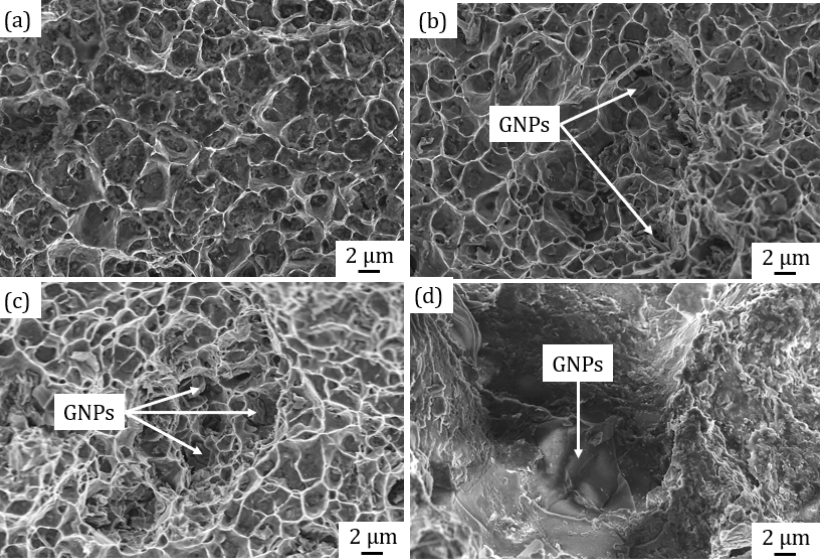
Figure 8. Fracture surface of ( a ) AlSi10Mg, ( b ) AlSi10Mg–0.5 wt.% GNPs, ( c ) AlSi10Mg–1 wt.% GNPs and ( d ) AlSi10Mg–2 wt.% GNPs after tensile test.